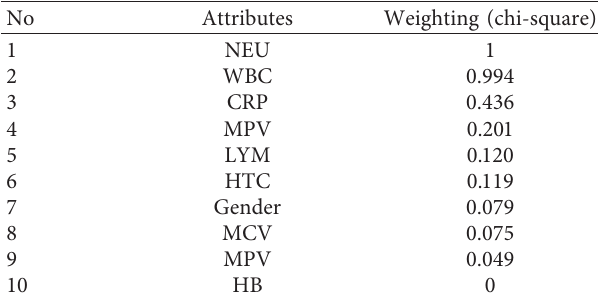
Table 3: Attributes and weighting.